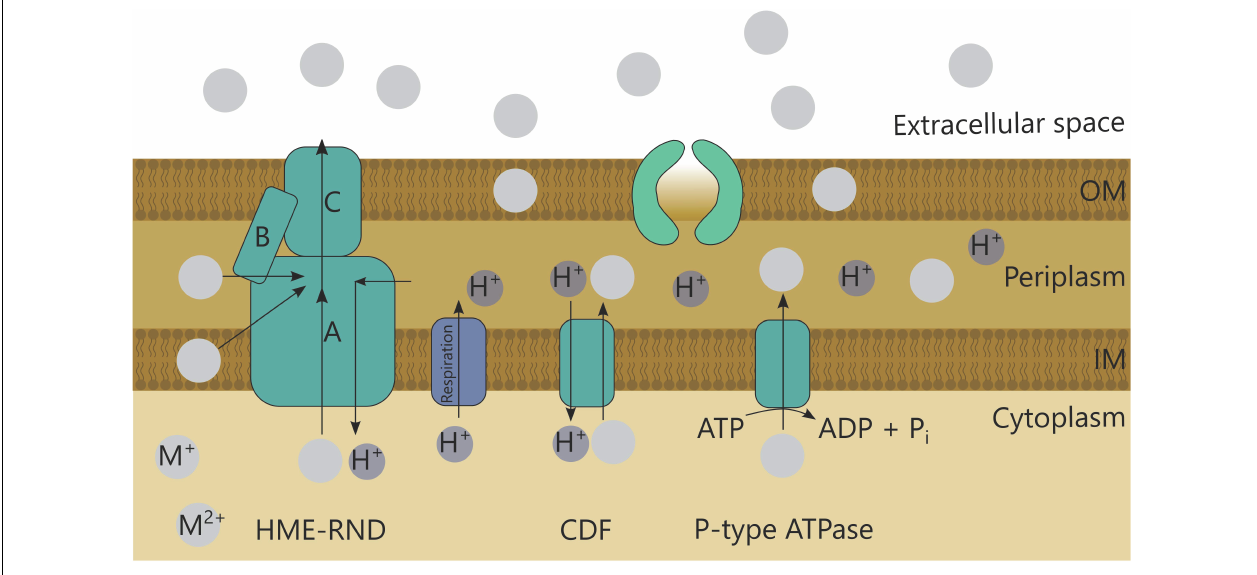
Frontiers in Microbiology |